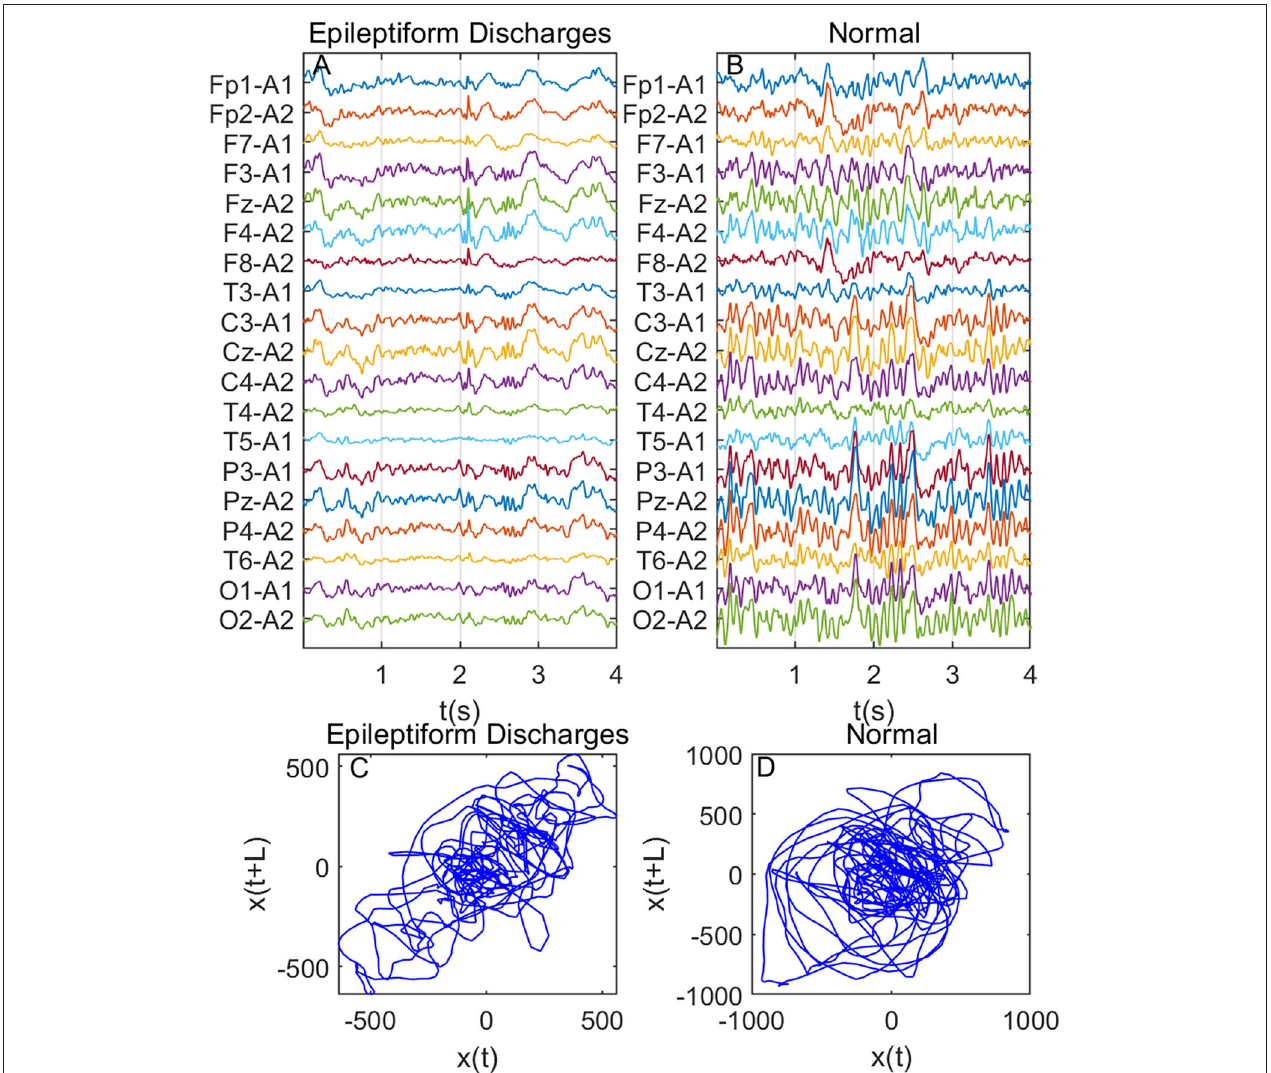
FIGURE 4 | Same as Figure 3 , except data were from another subject showing that Signal Range for epileptiform discharges can be smaller than that of normal EEG: (A) example of epileptic discharges, (B) normal EEG, (C,D) 2-D phase diagrams using the summation of the 19 epileptiform discharges and normal EEG signals shown in (A,B) , respectively, which can be used to estimate Signal